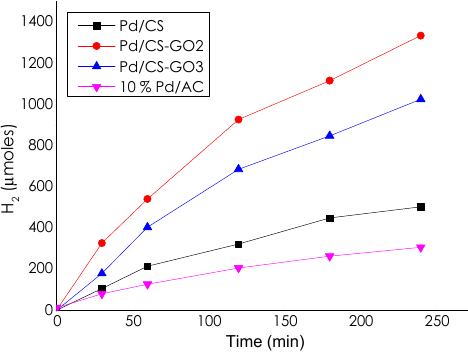
Figure 5. Temporal H 2 evolution by NH 4 HCO 2 decomposition catalyzed by Pd / CS, Pd / CS-GO2,